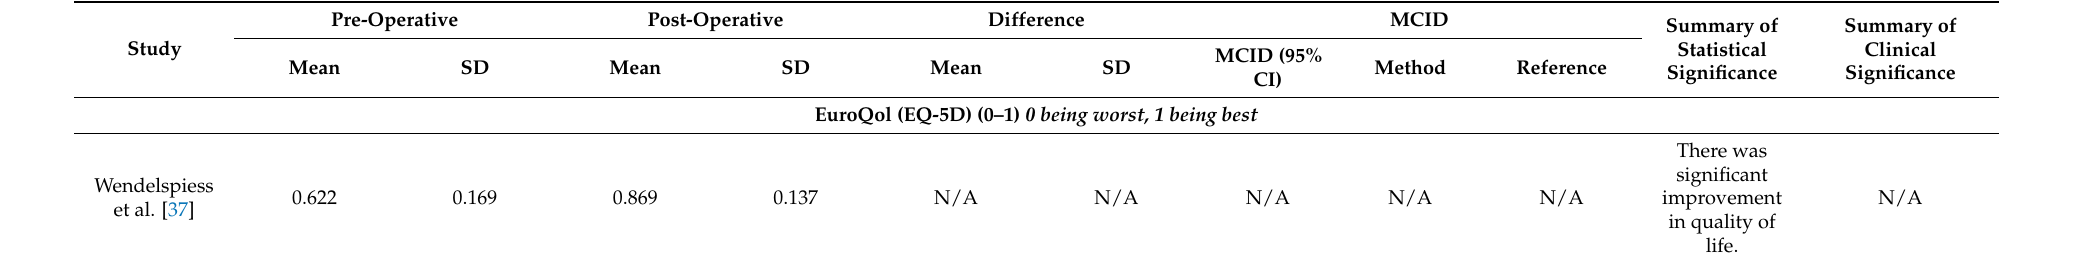
Table 5. Effect of total knee replacement on health-related quality of